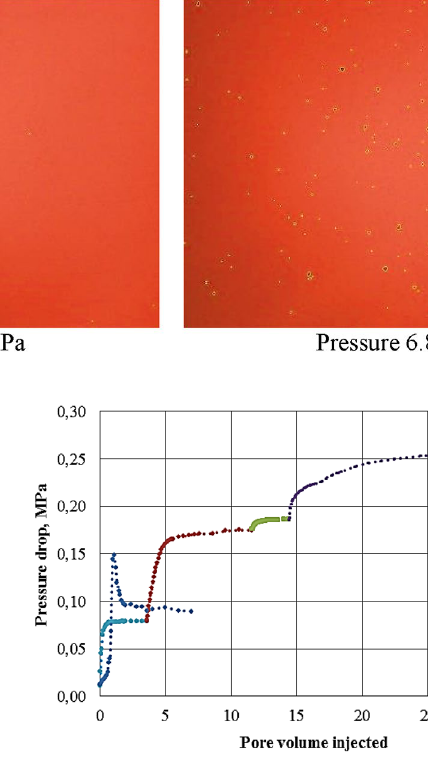
Fig. 7 Pressure drop versus pore volume injected at different back